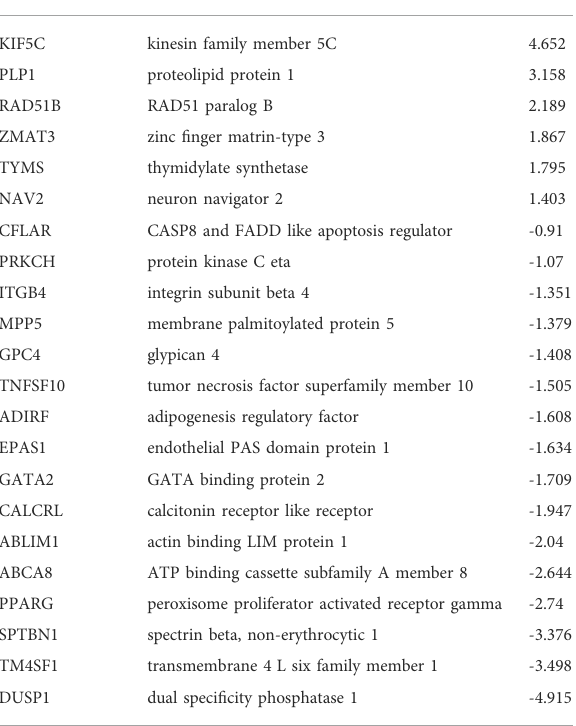
TABLE 2 Gene symbol of 22 differentially expressed